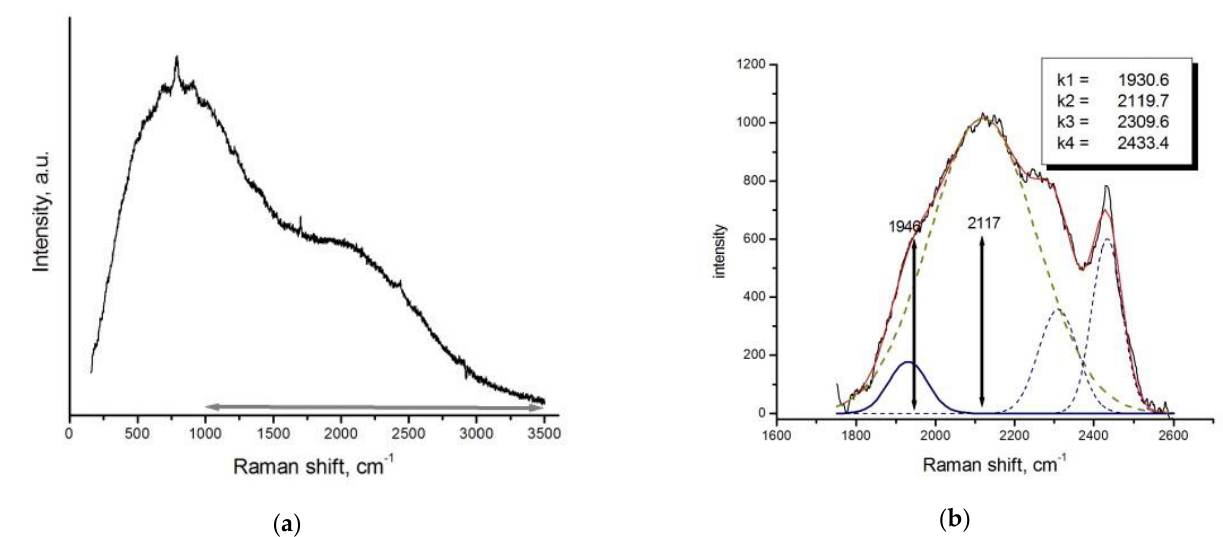
Figure 8. Spectrum of the solution in acetone of quenched phases in periclase matrix from the runs O59 measured with green laser (spectrum of pure acetone is subtracted), dissolution time 15 min: ( a ) fluorescence band with acetone spectrum subtracted; small sharp peaks and negative peak around 2800 cm − 1 are from not completely compensated acetone; ( b ) deconvolution of O59 spectrum minus fluorescence band; positions of peaks related to Pt carbonyls from Figure 7b are labeled by arrows.